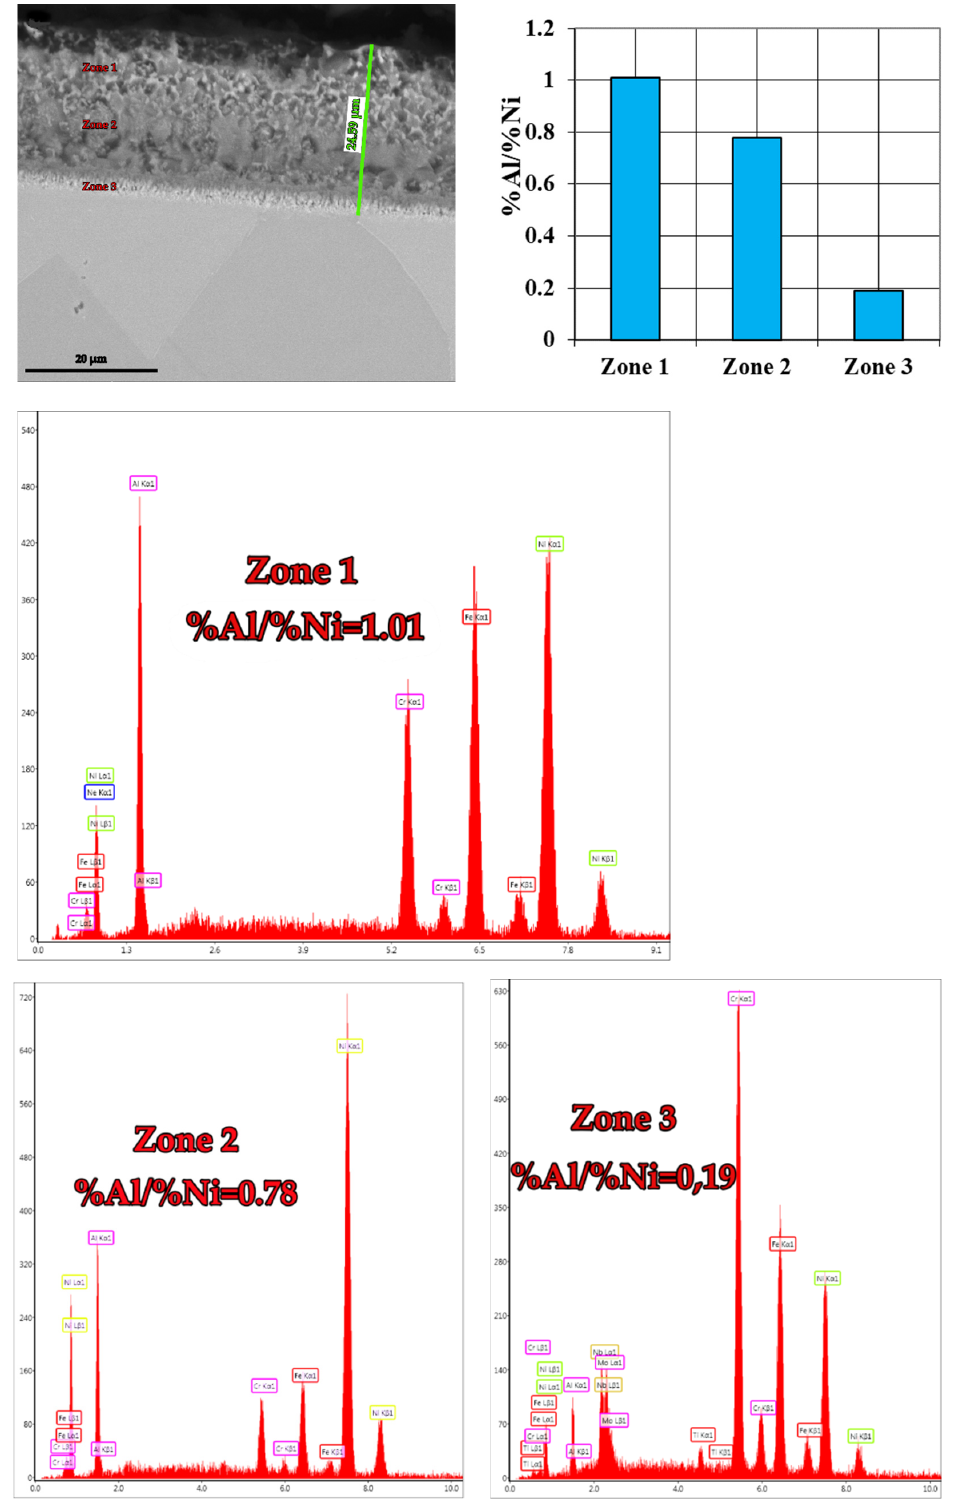
Figure 10. Aluminized IN 718 superalloy at 900 °C for 5 h, in a pack aluminizing mixture (49 wt.% Al + 49 wt.% Fe + 2 wt.% NH 4 Cl); SEM-EDS spectra corresponding to the different areas investigated, and the %Al/%Ni ratio in the investigated areas.